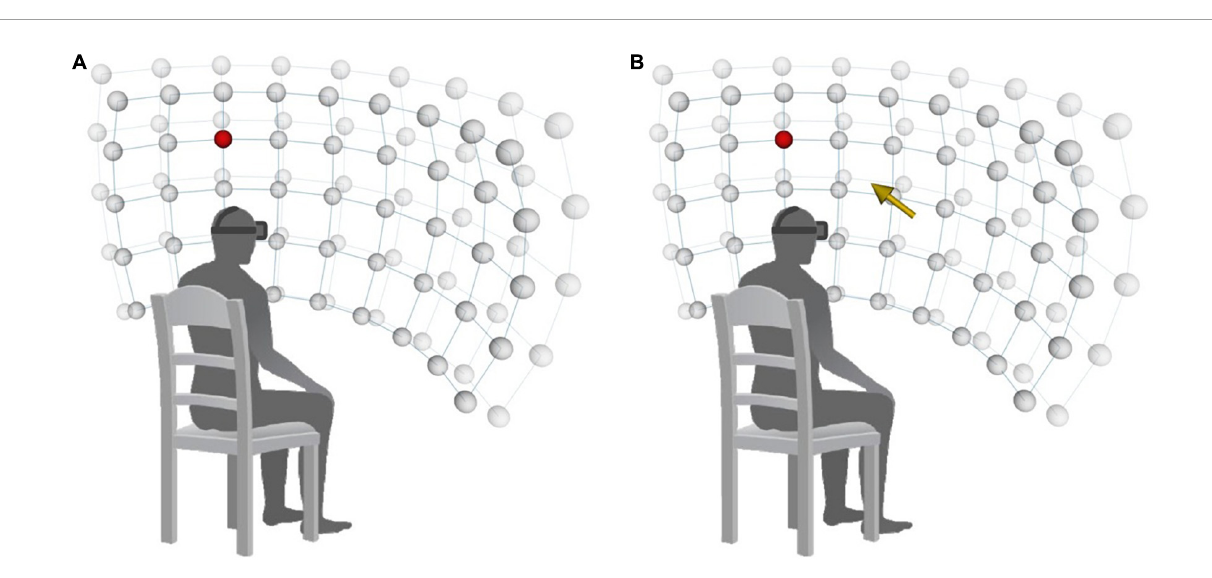
scores indicating better function. CBS is subdivided into